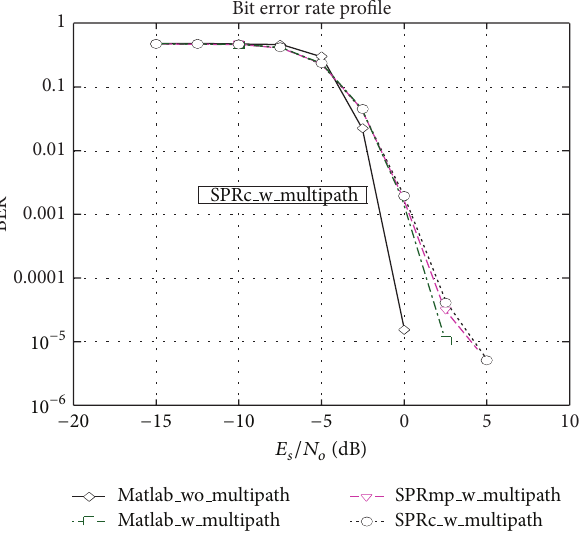
Figure 5: BER plot of the communication system.